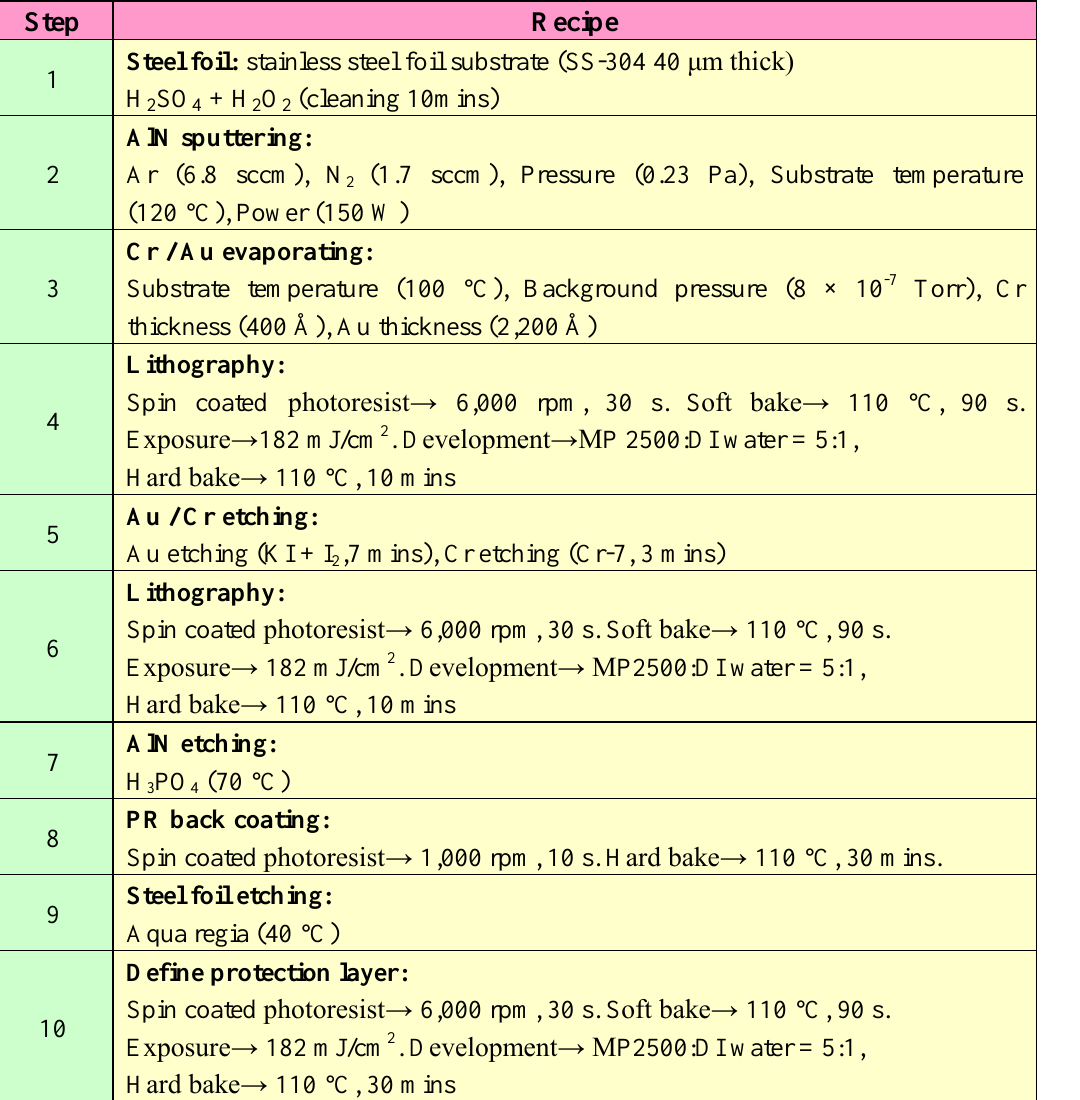
Table 1. Recipe for multi-functional flexible micro-sensors.